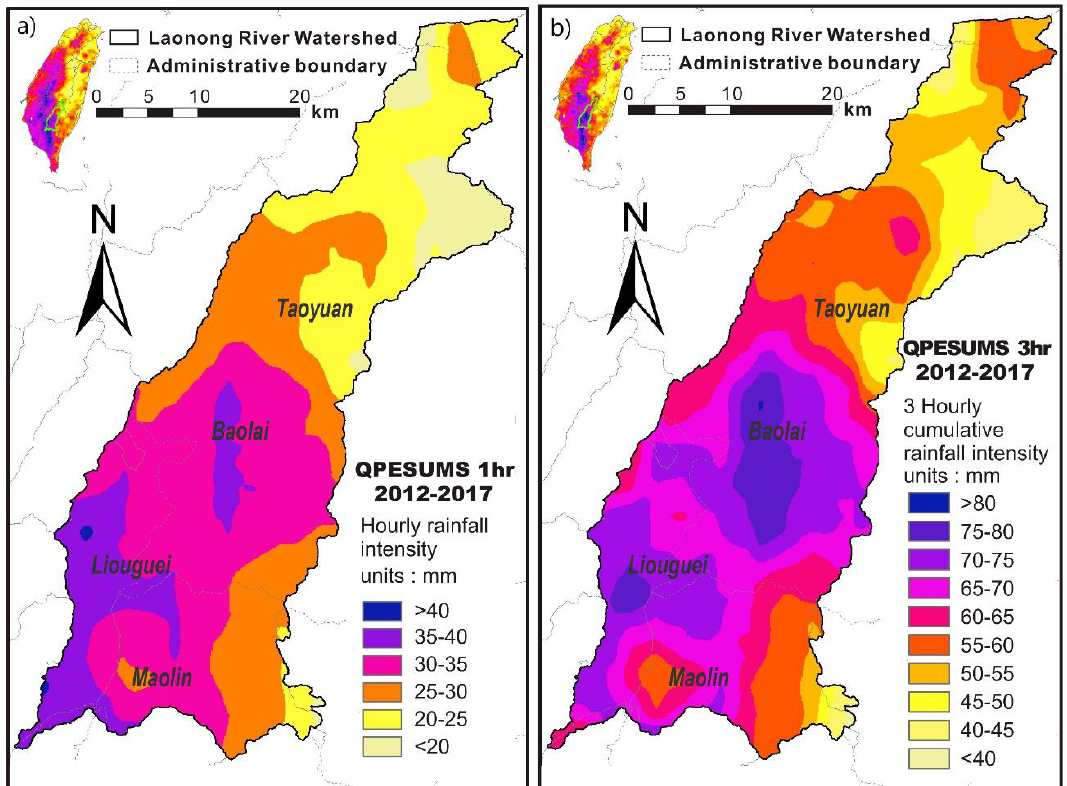
Figure 6. Spatial distribution of the top 1% of rainfall intensity in the Laonong River watershed: ( a ) hourly rainfall and ( b ) 3 h accumulated rainfall.